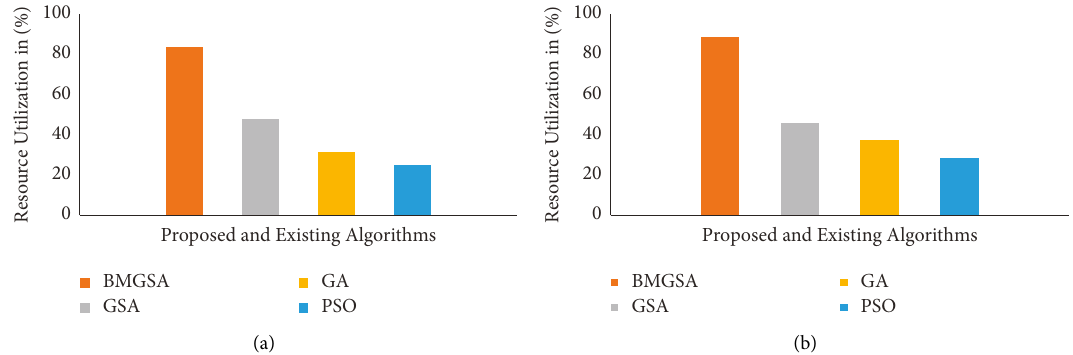
Figure 6: Resource utilization of the proposed and existing techniques. (a) Resource utilization using Google Cluster and (b) resource utilization using PlanetLab.